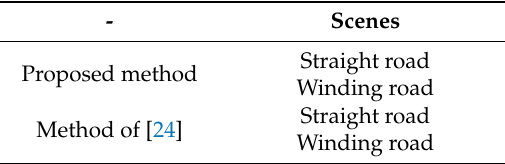
Table 3. Accuracy of the curb detection method.